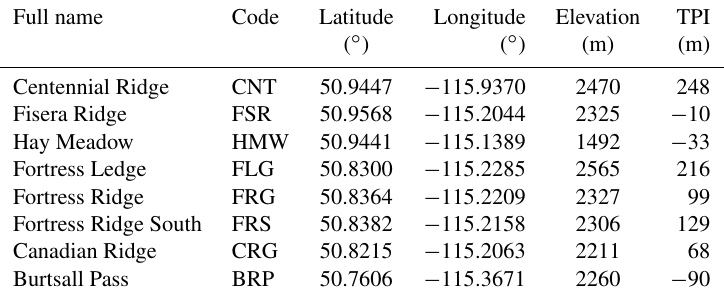
Table 3. Meteorological stations used for wind evaluation. TPI refers to the topographic position index and is defined as the difference between the elevation of the station minus the mean elevation within a 2km radius from this station. The location of the stations is shown in Fig.